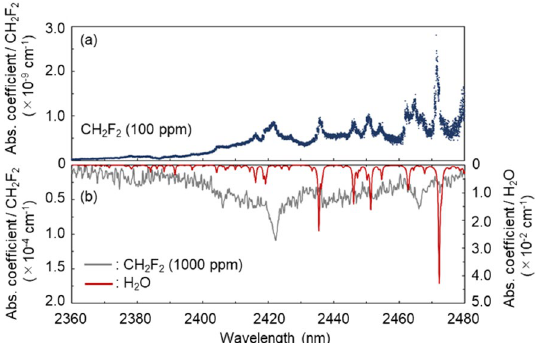
Figure 5. ( a ) CRD absorption spectrum of CH 2 F 2 (100 ppm) in the 2360–2480 nm region. ( b ) CH 2 F 2 (1000 ppm) absorption spectrum measured by FTIR spectroscopy (gray curve) and pure H 2 O absorption spectrum simulated using the HITRAN database (red